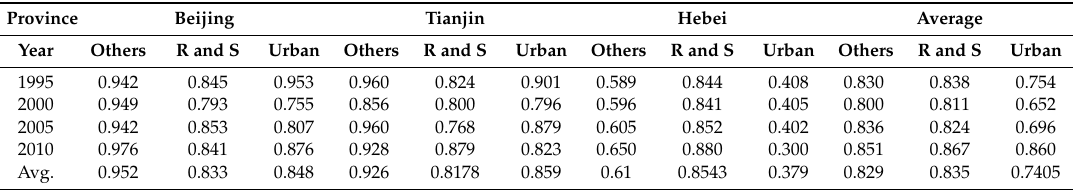
Table 4. Accuracies for di ff erent land use types.